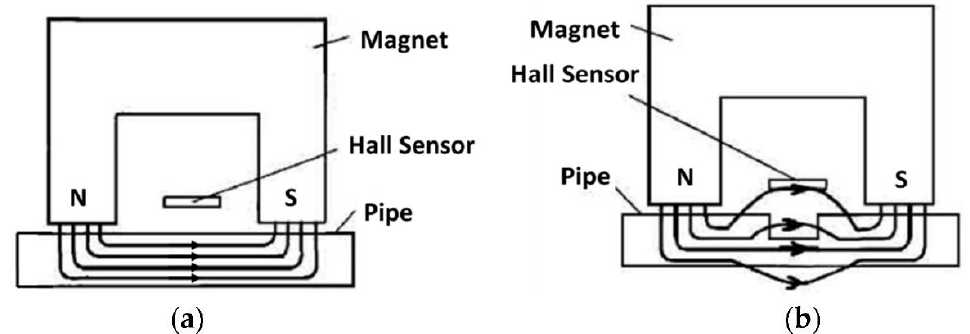
Figure 5. The principal of a magnetic flux leak sensor that can measure the flux passing through and interpret it to give meaningful results [83]. ( a ) A ferromagnetic material only has all the lines inside it. ( b ) Hall-effect sensor.